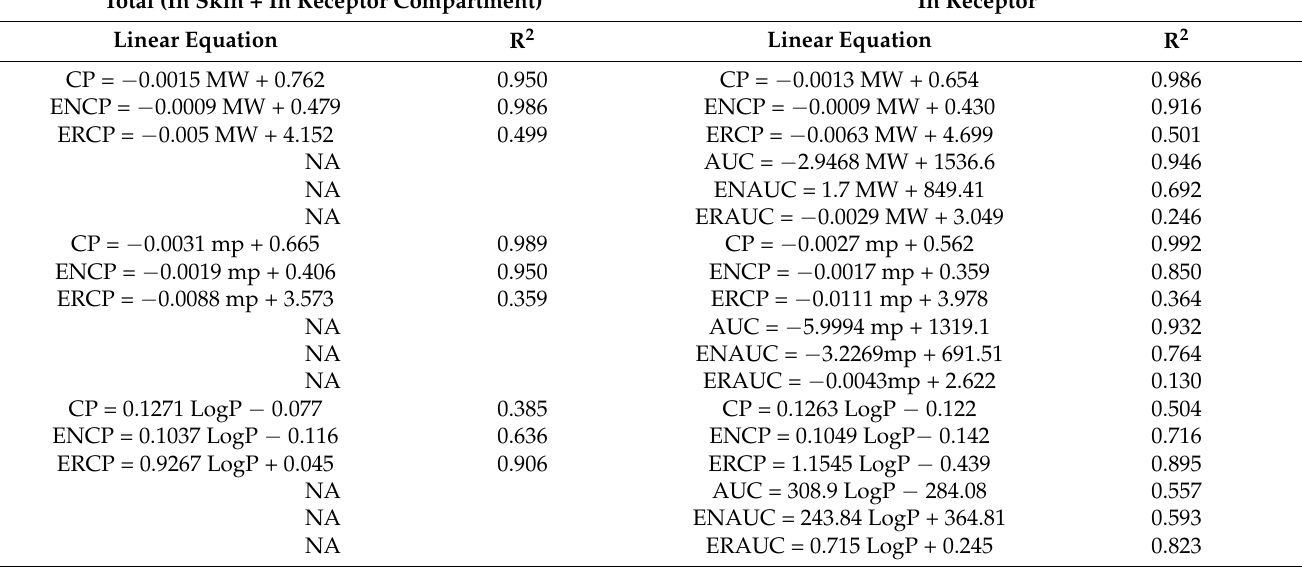
Table 2. Linear regression of the skin permeation parameters obtained from ibuprofen, lidocaine, tofacitinib citrate, and rhodamine B. Ibuprofen sodium was excluded in the regression analysis The cumulative permeation (CP), CP enhancement (EN CP ), and CP enhancement ratio (ER CP ) as dependent variables, and logP, mp and MW as independent variables. The AUC, AUC enhancement (EN AUC ) and AUC enhancement ratio (ER AUC ) were not applicable (NA) to total skin permeation. Total (In Skin + In Receptor Compartment) In Receptor Linear